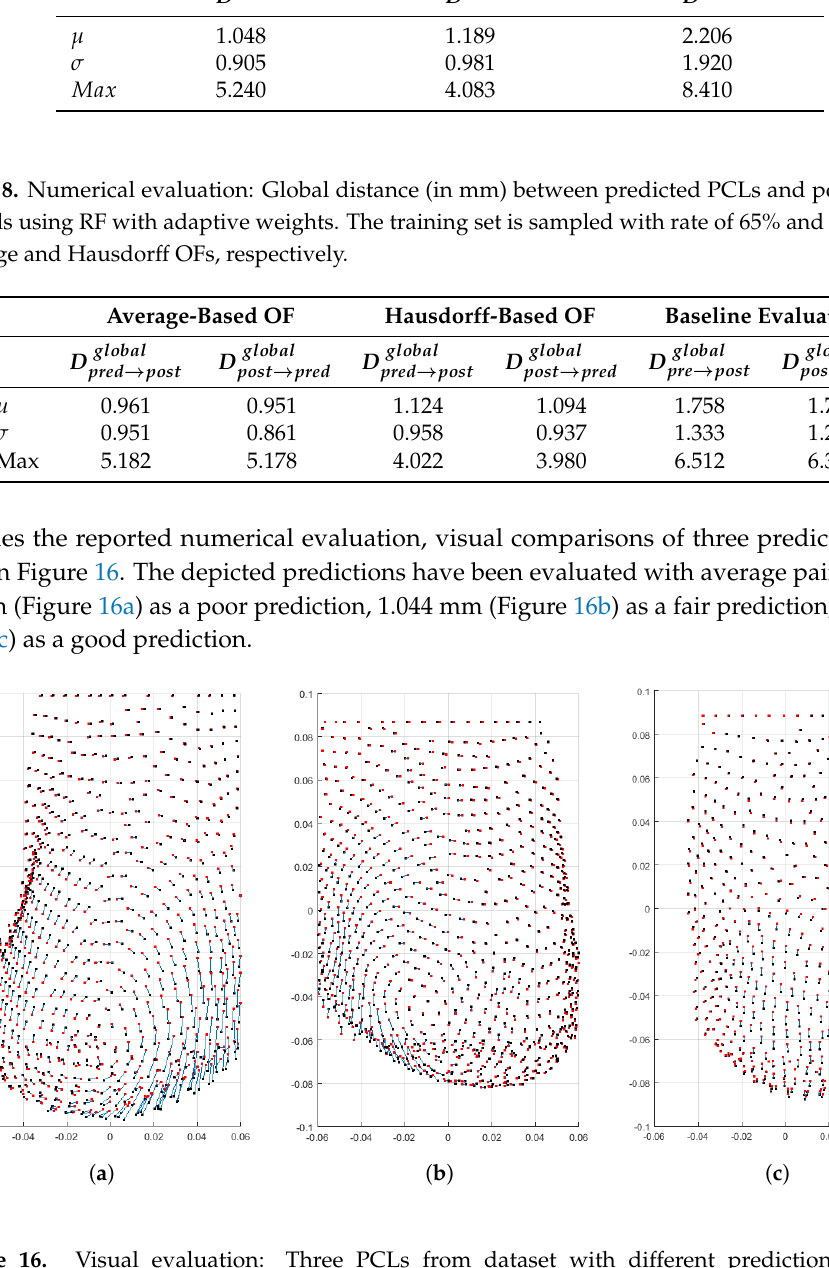
Figure 16. Visual evaluation: Three PCLs from dataset with different prediction distances. The post-surgery PCL is shown with red points while the predicted PCL is visualized with black points. The displacements between corresponding points are colored in blue. ( a ) Poor prediction, D pred → post = 1.624 mm; ( b ) Fair prediction, D pred → post = 1.044 mm; ( c ) Good prediction, D pred → post = 0.827